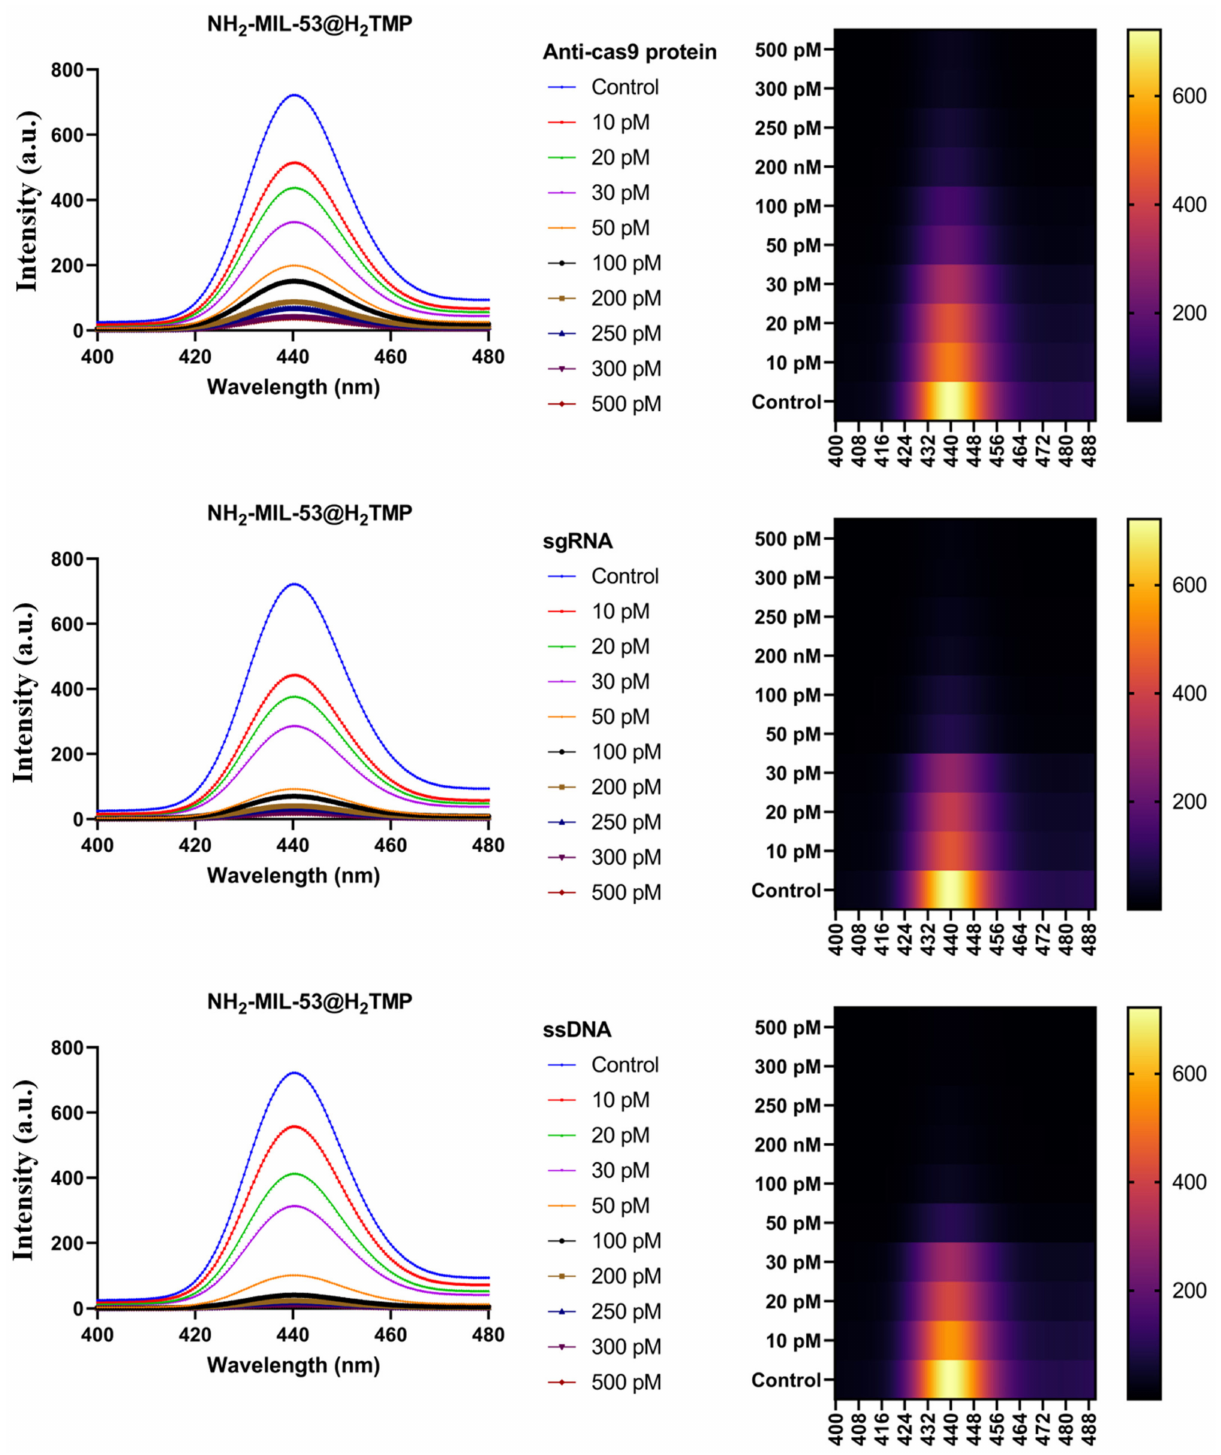
Figure 8. Fluorescence emission spectra of the NH 2 -MIL-53@H 2 TMP in the presence of Anti-cas9 protein, sgRNA, and